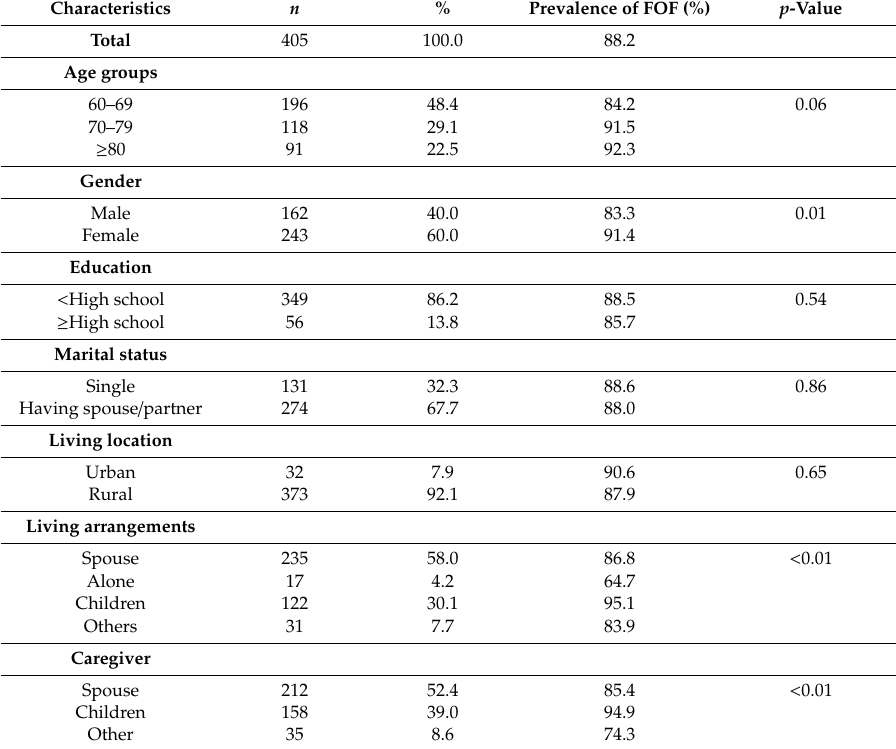
Table 1. Prevalence of fear of falling according to sociodemographic characteristics of